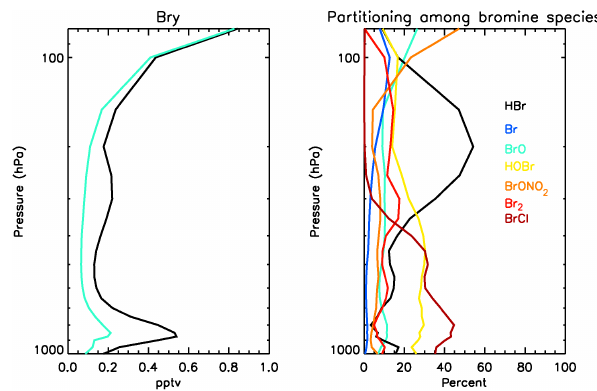
Figure 16. Left: profile of the daily (12 January 2005) mean mixing ratios of Br y simulated by the model in the larger grid (50km × 50km) in S1_HighT (black) and in S0 (light blue). Right: daily mean (12 January 2005) of the Br speciation (%) for the simulation S1_HighT for grid boxes where Br y mean difference between S1_HighT and S0 is larger than 0.5pptv (Fig. 15). Figure 17. Daily mean difference (12 January 2005) between simu-